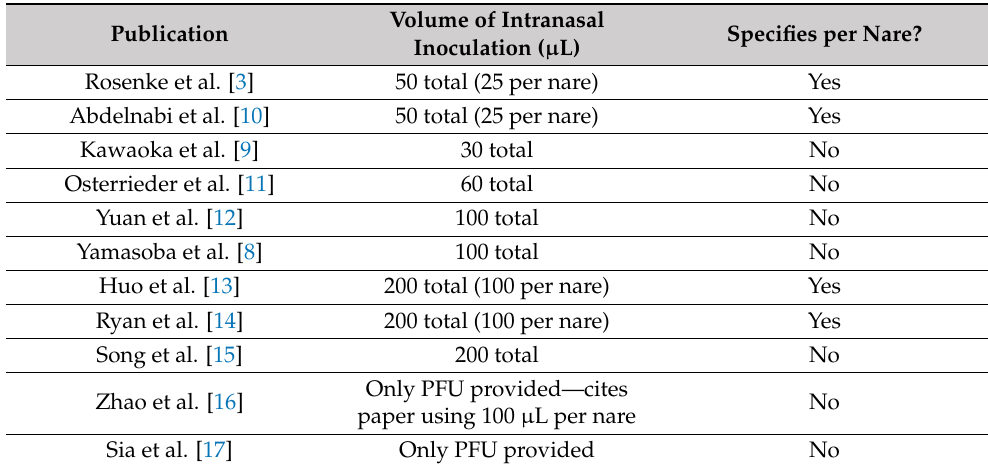
Table 1. An illustration of the variation in intranasal challenge inoculum volume found in the literature. This is a representative sample and